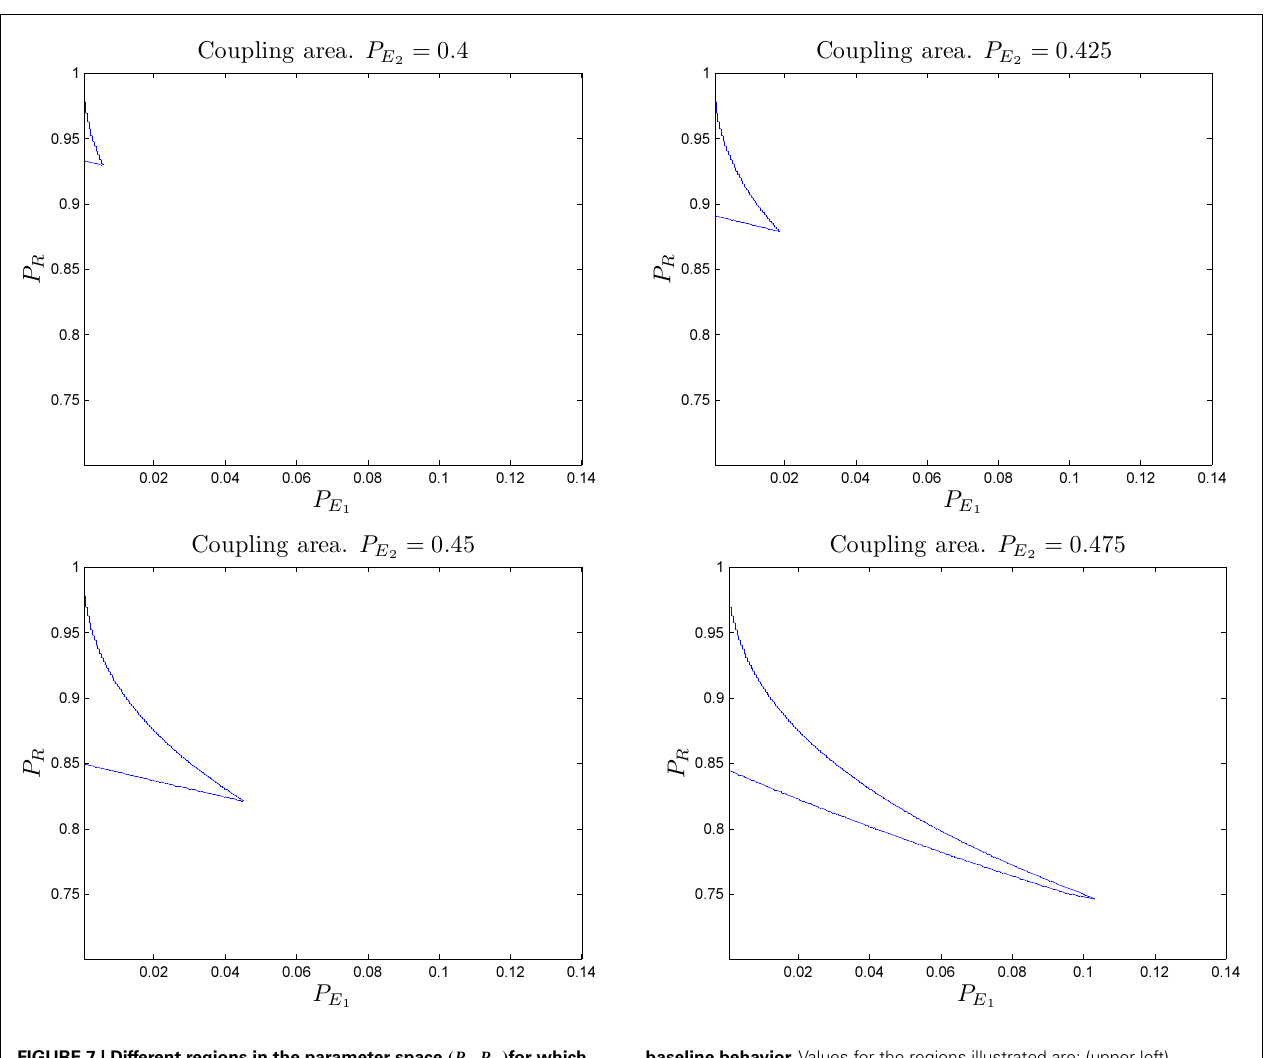
FIGURE 7 | Different regions in the parameter space ( P R , P E wrong somatic markers cooperate with a “bad” reasoning/primary emotional system to form a decision-making system with better than